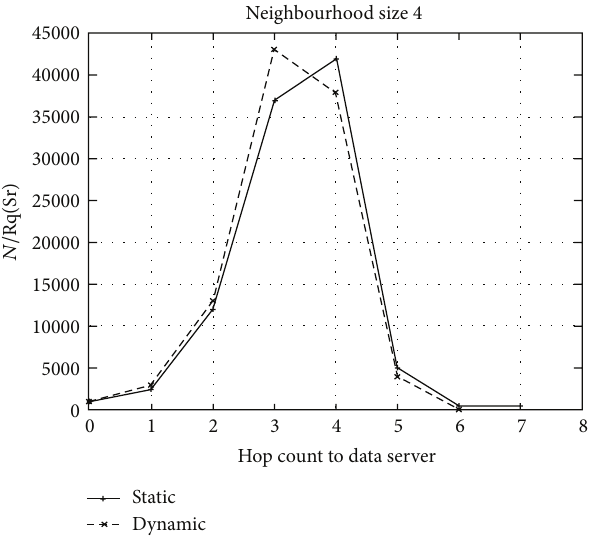
Figure 9: Compare dynamic versus static adjacent list size (4)